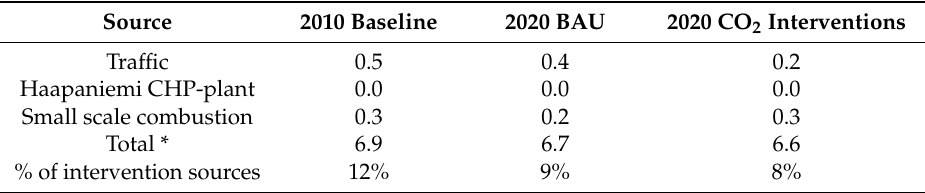
Table 5. Annual average concentrations of PM 2.5 ( µ g/m 3